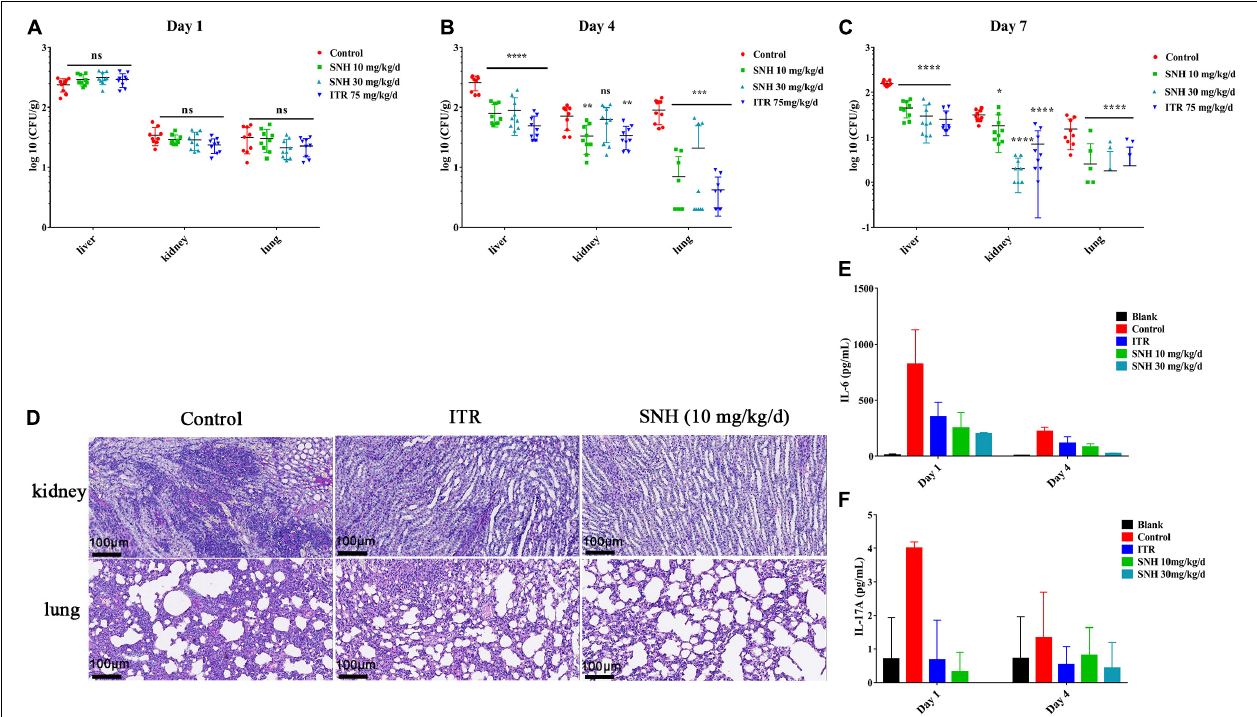
FIGURE 6 | Therapeutic effect of sodium new houttuyfonate (SNH) on invasive aspergillosis (IA) in mice. (A–C) Fungal burden of the lung, kidney, and liver. The IA model mice were treated by gastric gavage with SNH at 10 mg/kg/d and 30 mg/kg/d, and the fungal burden was measured at 1–, 4–, and 7-days posttreatment. (D) Histological analysis of mice with IA. PAS-stained sections were prepared from the kidneys and lungs of mice 7 days after treatment with SNH at 10 mg/kg/d. Scale bar is 100 µ m. (E,F) Determination of cytokines. Levels of IL-6 and IL-17A in various groups of mice serum on days 1 and 4 after treatment with SNH are shown. Each cytokine assay was performed three times, and the values represent average ± SD of three data points. Normal saline and ITR-treated IA mice were used in the control group, respectively. The statistical significance level was set at * P < 0.05. ** P < 0.01, *** P < 0.001, and **** P < 0.0001; ns indicates no statistical significance compared with untreated mice with